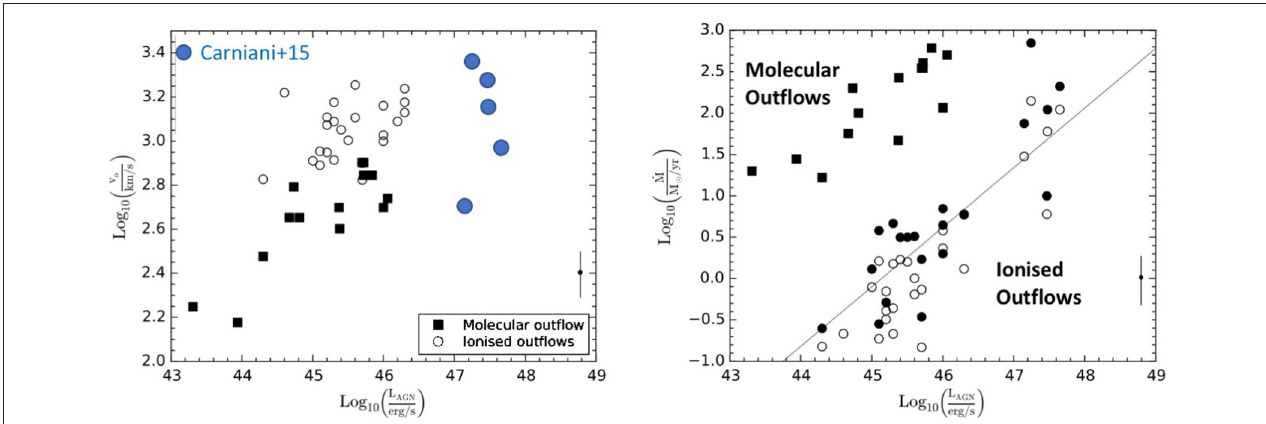
FIGURE 1 | Outflow velocity (left) and mass rate (right) vs. AGN luminosity (Figure is an adaption from Carniani et al., 2015). Open circles represent the estimates of ionized outflows obtained from [O III ] λ 5007 line, while the filled marks are based on H β . A representative error bar is shown at right in each plot and it corresponds to an average error of ± 0.2 dex for the outflow velocity and ± 0.3 dex for the outflow mass rate. The errors take also in account for uncertainties due to projection effects. The best-fit ˙ M o − L AGN relation for the ionized outflows is indicated in the panel with a black line. Square points indicate velocities and outflow rate inferred from molecular outflows. Carniani, A&A, 580, A102, 2015, reproduced with permission © ESO.